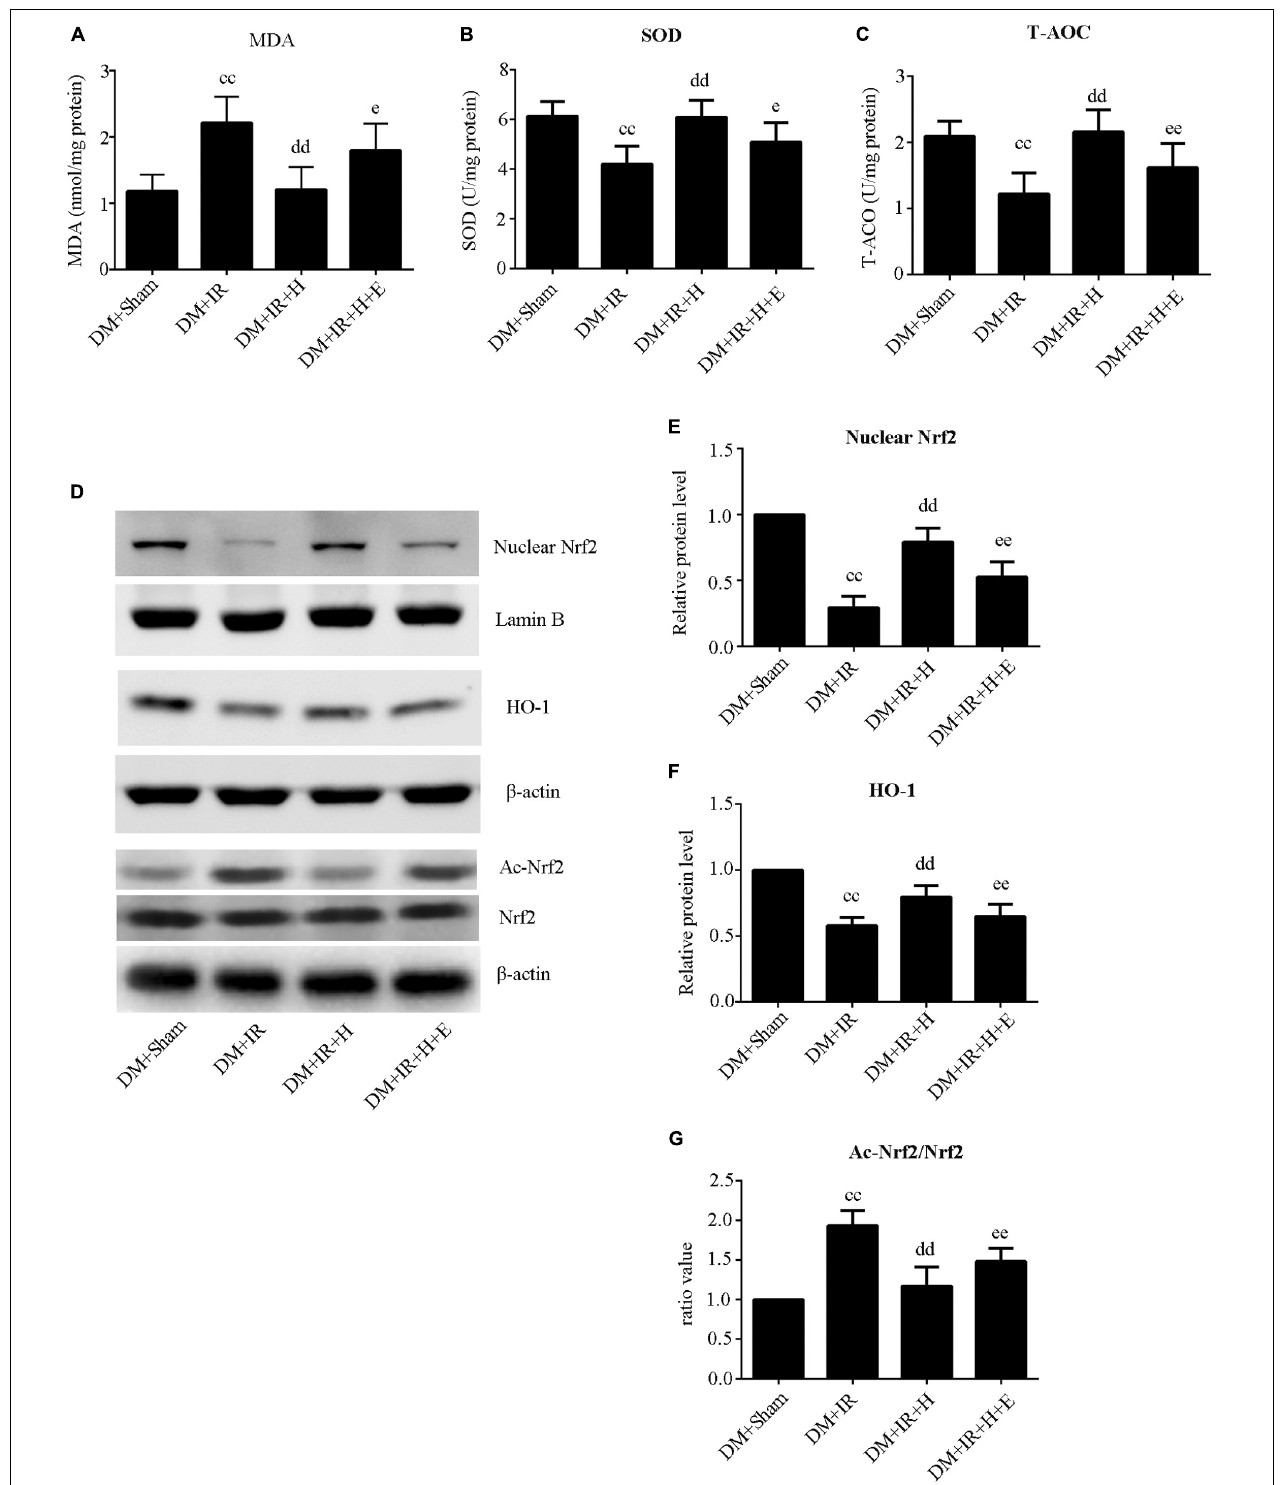
FIGURE 5 | EX527 abolished GYY4137-induced suppression of the oxidative stress level in diabetic lung IR injury. (A) SOD concentration. (B) T-AOC concentration. (C) MDA concentration. (D) Representative blots. (E) Nuclear Nrf2 expression. (F) HO-1 expression. (G) The ratio of Ac-Nrf2/Nrf2. Ac-Nrf2, acetylated erythroid 2-related factor 2; Nrf2, Erythroid 2-related factor 2; HO-1, heme oxygenase 1 ( cc P < 0.01 versus DM + sham group, dd P < 0.01 versus DM + IR group, e P < 0.05 versus DM + IR + H group/ ee P < 0.01 versus DM + IR + H group; n = 8 in each group).